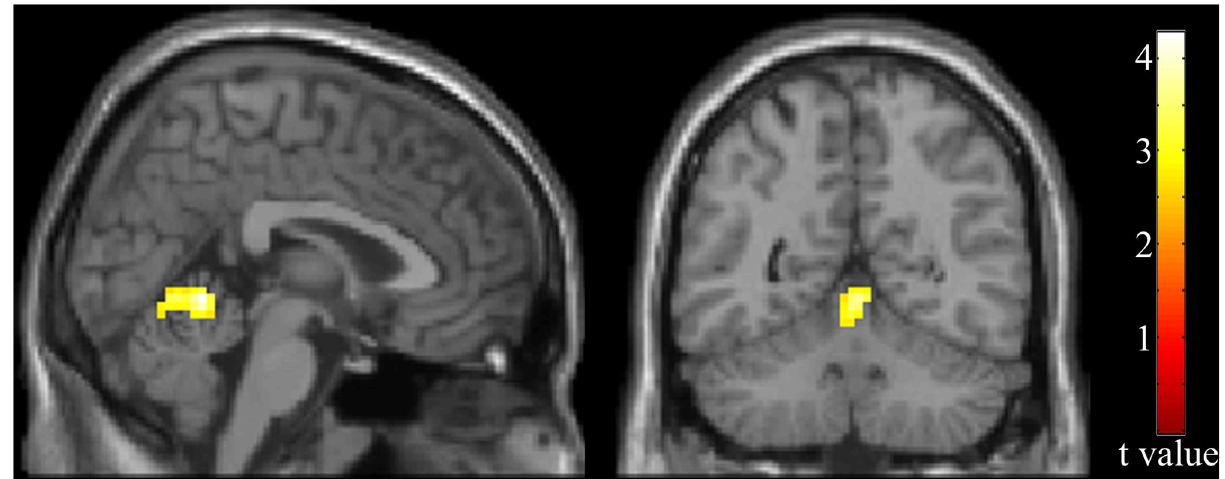
Figure 1. Hemodynamic response due to nicotine treatment during an auditory-paced finger tapping task. Shown is the treatment effect of nicotine in task-related ROIs, with all voxels thresholded at p < 0.01, uncorrected. Cluster was significant using small volume correction with FDR (k=54, T(max)=4.26, df=18, p=0.015). doi: